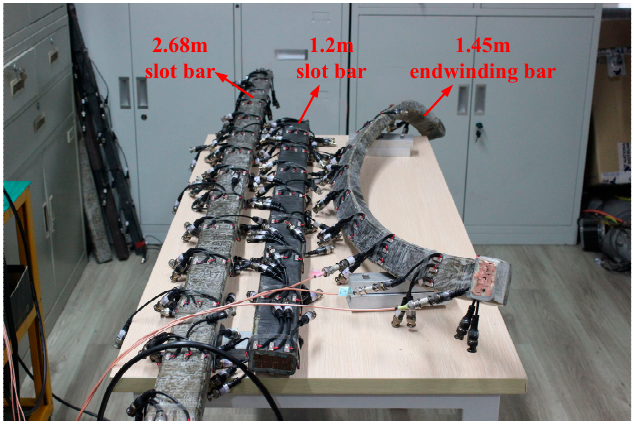
Figure 9. Specimen of stator bars in damage detection experiments.